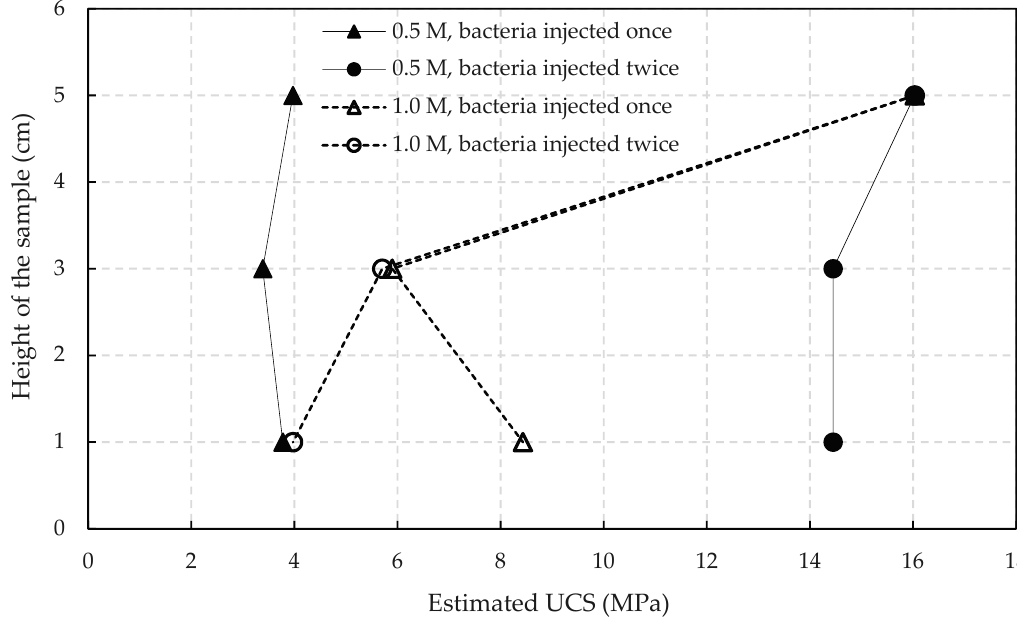
Figure 7. Variation of local strength of microbial induced carbonate precipitation (MICP) treated sand under different bacteria and reactant concentrations.